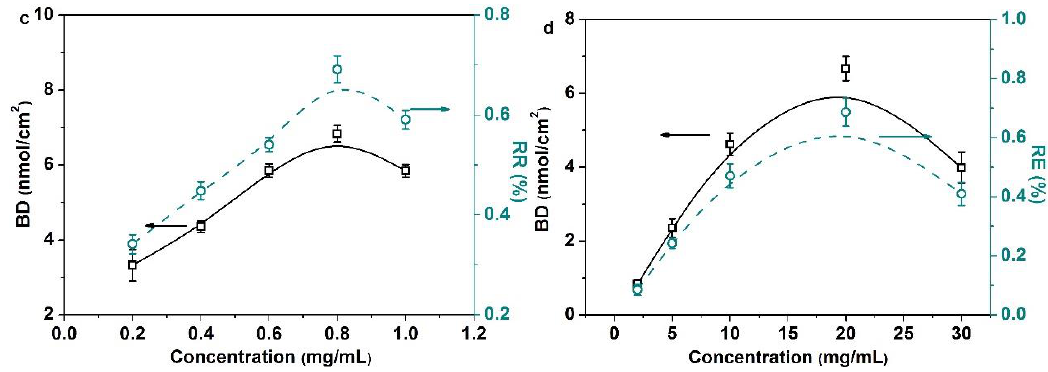
Figure 2. There are four typical influencing factors which a ff ect enzyme-catalyzed transglycosylation. ( a ) Influence of reaction time on the BD and the RE (enzyme concentration (0.8 mg / mL), lactose concentration (10 mg / mL), POEGMA GD (350 µ g / cm 2 )); ( b ) influence of POEGMA GD on the BD and the RE (enzyme concentration (0.8 mg / mL), lactose concentration (10 mg / mL), reaction time (72 h)); ( c ) influence of enzyme concentration on the BD and the RE (POEGMA GD (350 µ g / cm 2 ), lactose concentration (10 mg / mL), reaction time (72 h)); ( d ) influence of lactose concentration on the BD and the RE (POEGMA GD (350 µ g / cm 2 ), enzyme concentration (0.8 mg / mL), reaction time (72